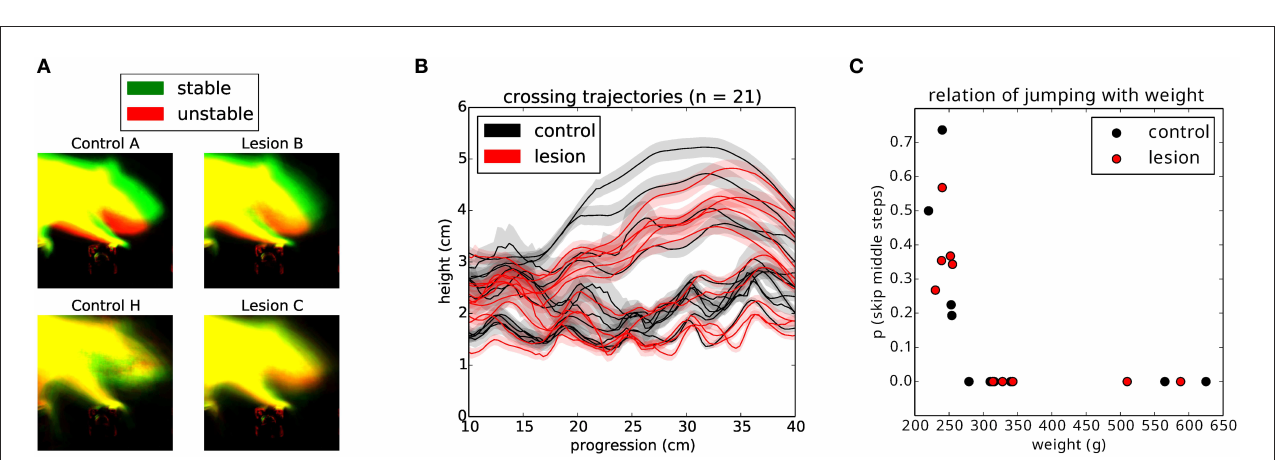
FIGURE7 Animals use different strategies for dealing with the unstable obstacles. (A) Example average projection of all posture images for stable (green) and unstable (red) sessions for two non-jumper (top) and two jumper (bottom) animals. (B) Average nose trajectories for individual animals crossing the unstable condition. The shaded area around each line represents the 95% confidence interval. (C) Relationship of the weight of the animal to the probability of skipping the center two steps.